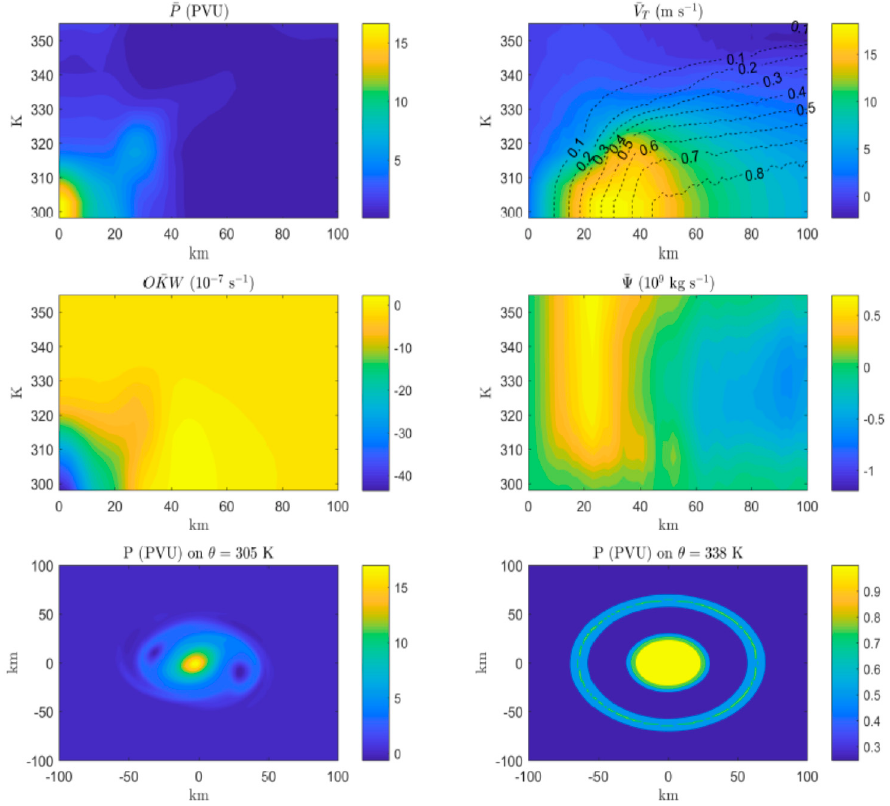
Figure 5. Same as Figure 2, except for (cid:1872) = 48 h .